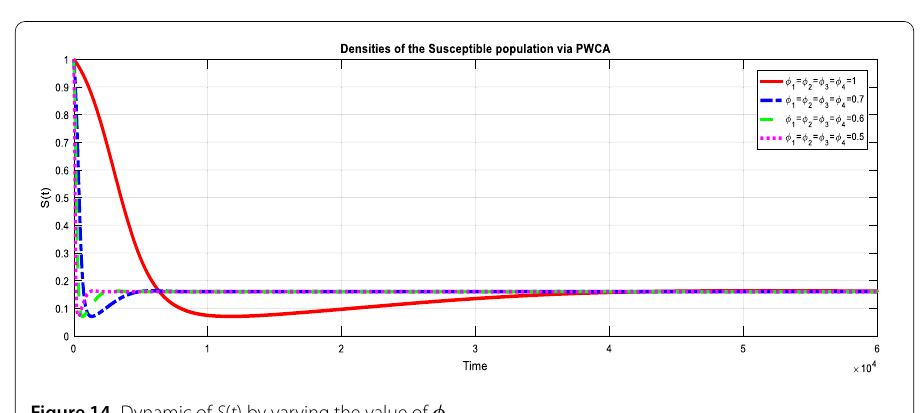
Figure 14 Dynamic of S ( t ) by varying the value of φ